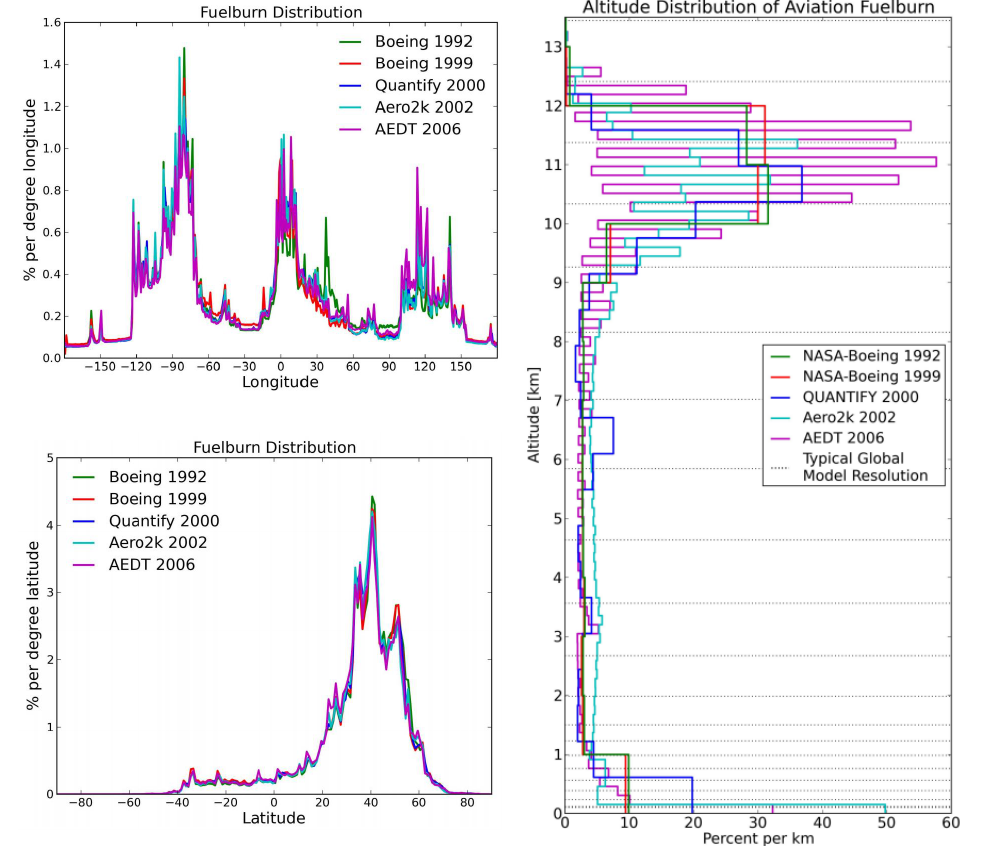
Figure 7. Spatial (latitude, longitude and altitude) distribution of global aviation fuel burn from a range of aircraft emissions datasets. Figure obtained from Olsen et al. [77] licensed under CC BY 3.0.